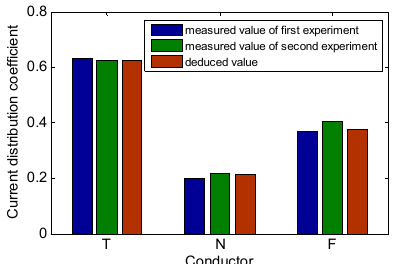
Figure 8. Comparison between measurement results and results of deduction for the current distribution.